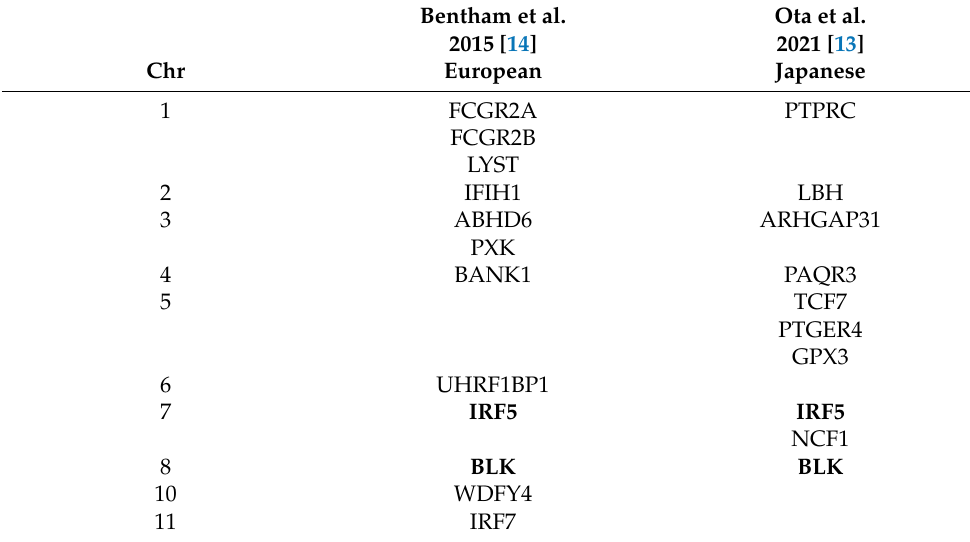
Table 1. List of eGenes for SLE-GWAS SNP.